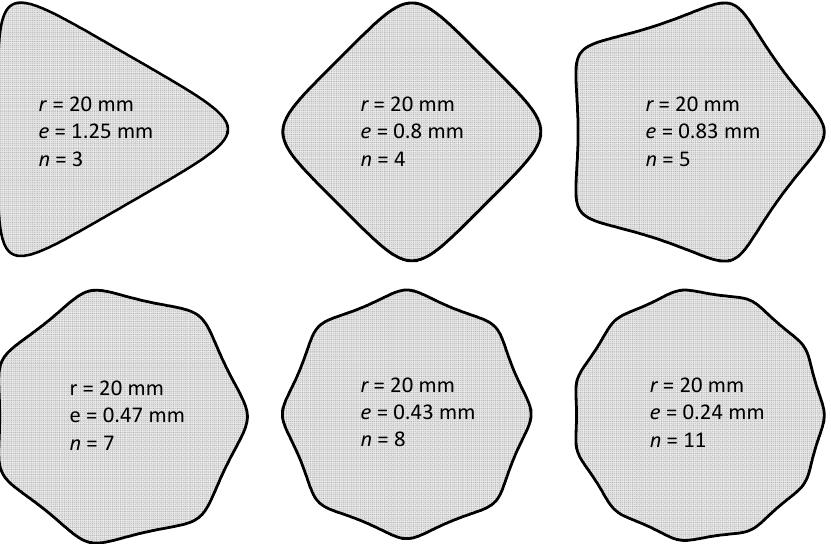
Figure 4. Examples of H-profiles with different numbers of sides ( n ) and eccentricities.